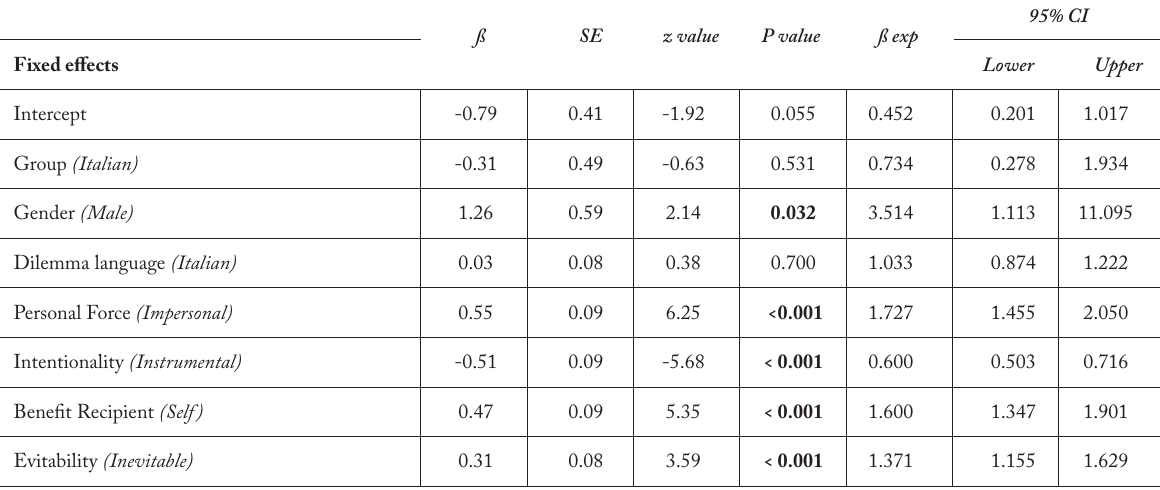
Table 2. Summary of linear mixed effects model on moral decisions for Study